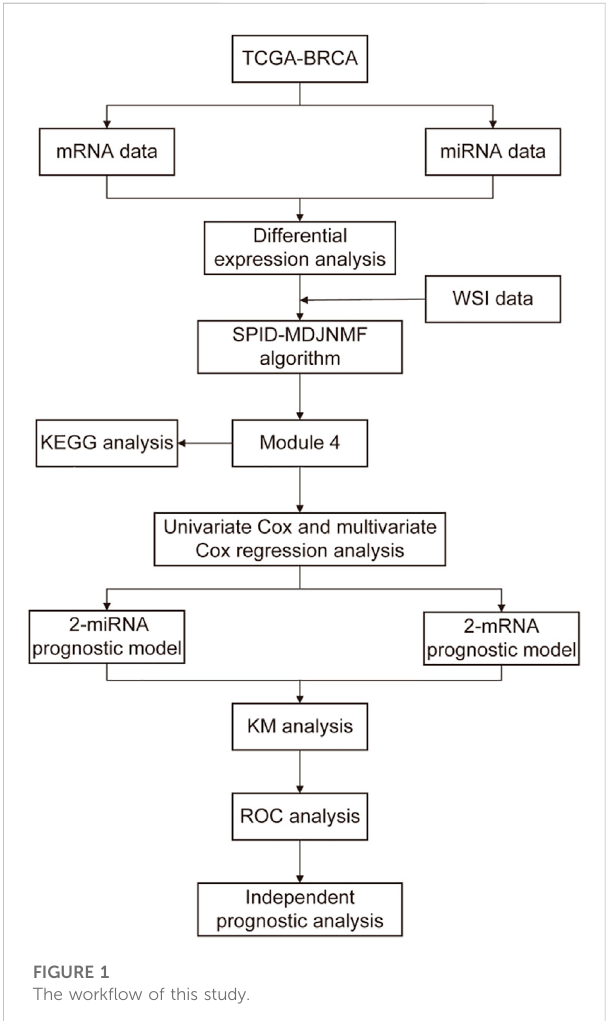
FIGURE 1 The work fl ow of this